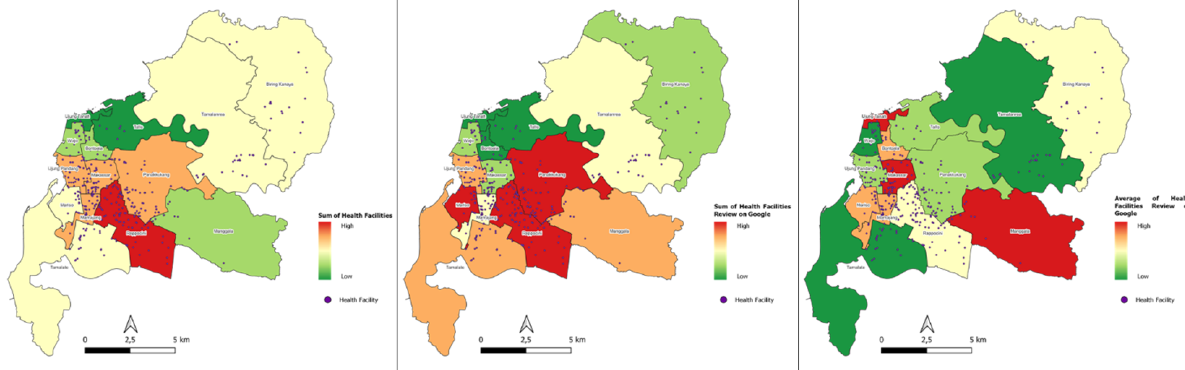
Figure 7. Map of Health Facility Service Concentration by Kecamatan administrative boundary.